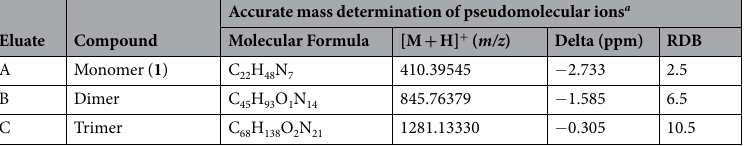
Table 2. Accurate mass data. a Accurate mass measurements and chemical formulas calculation were found through LTQ-Orbitrap XL and proposed chemical formulas, m/z values, RDB and Delta values were obtained from the software Xcalibur (Thermo Scientific, Bremen, Germany), as reported in “Experimental section - Accurate mass and fragmentation studies